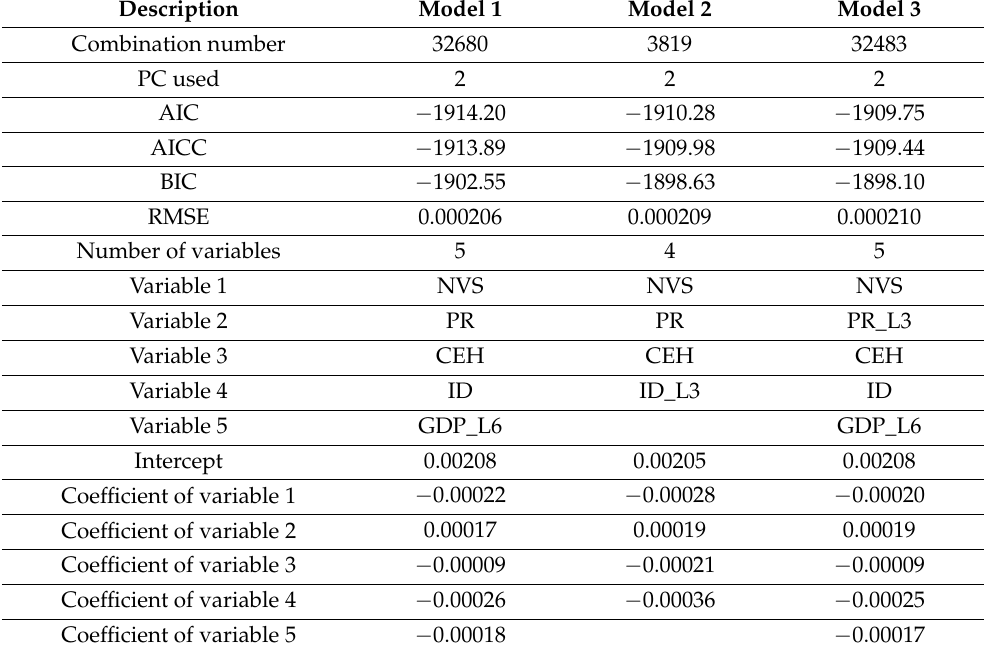
Table 4. Top three PCR models ranked by